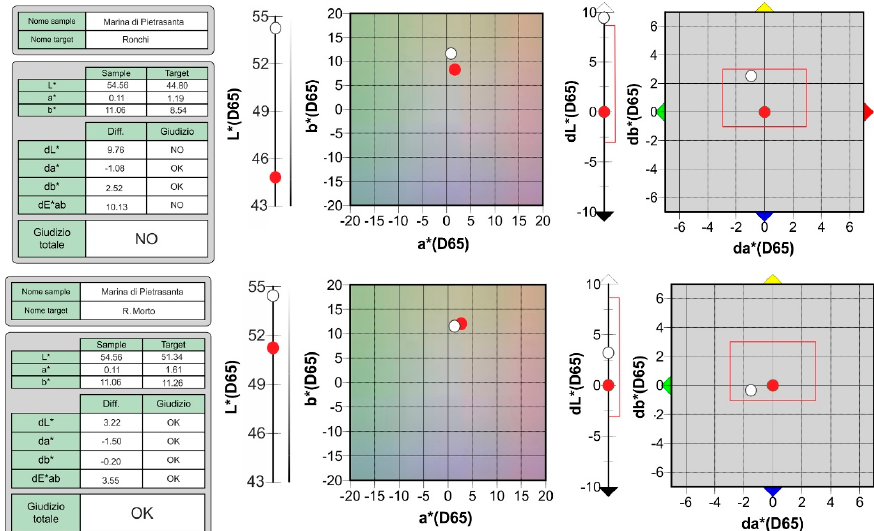
Figure 13. Colour compatibility of Marina di Pietrasanta sand with that of Ronchi beach (Sector 5) and of Morto River beach (Sector 12). Acceptability range is delimited in red on dL* axis, with a red rectangle on a*,b* plain. The left graph shows L* and a*b* absolute values of native (withe dot) and borrowed (red dot) sediments; the right graphs show the distance of borrowed sediments from native ones.